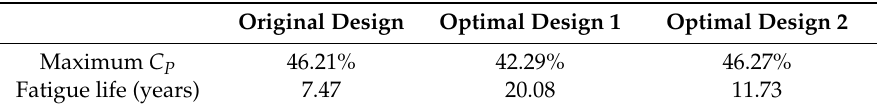
Table 3. Original and optimal designs.